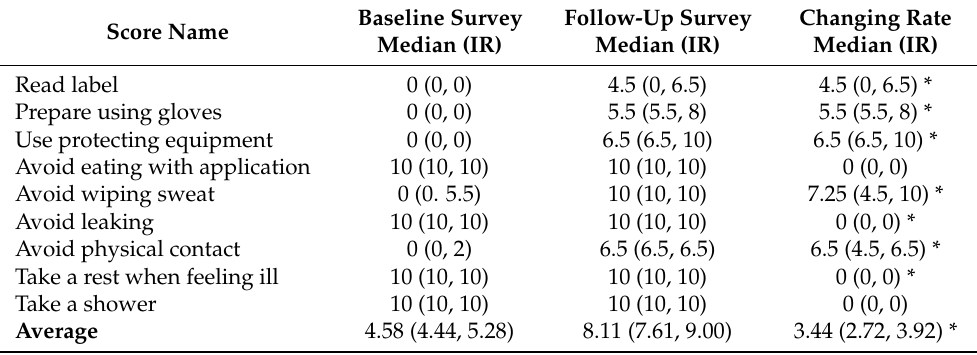
Table 2. Frequency scores of protective behaviors during pesticide application in each survey (10 = always, 0 = never).